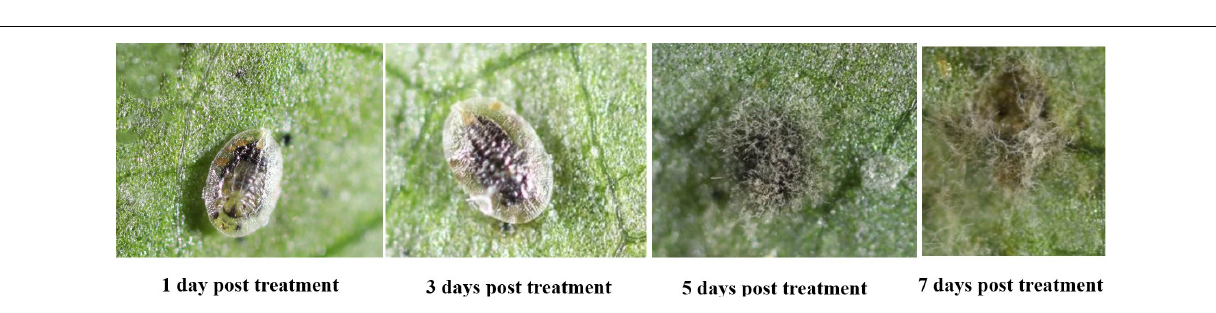
FIGURE 11 | Images of Bemisia tabaci infection by Cordyceps fumosorosea -biochar nanoparticles at 1, 3, 5, and 7 days